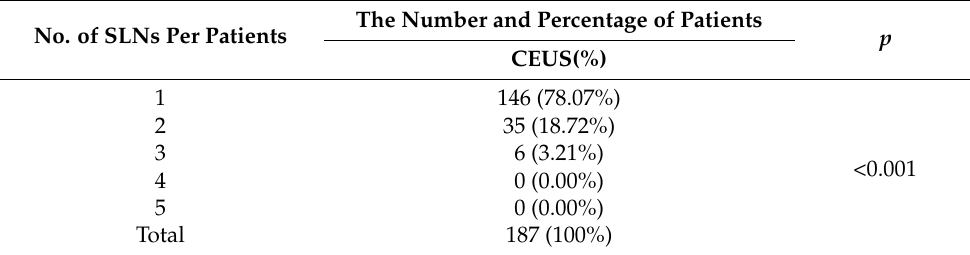
Table 2. CEUS preoperatively detected the number of SLN in women with early breast cancer ( n = 187).